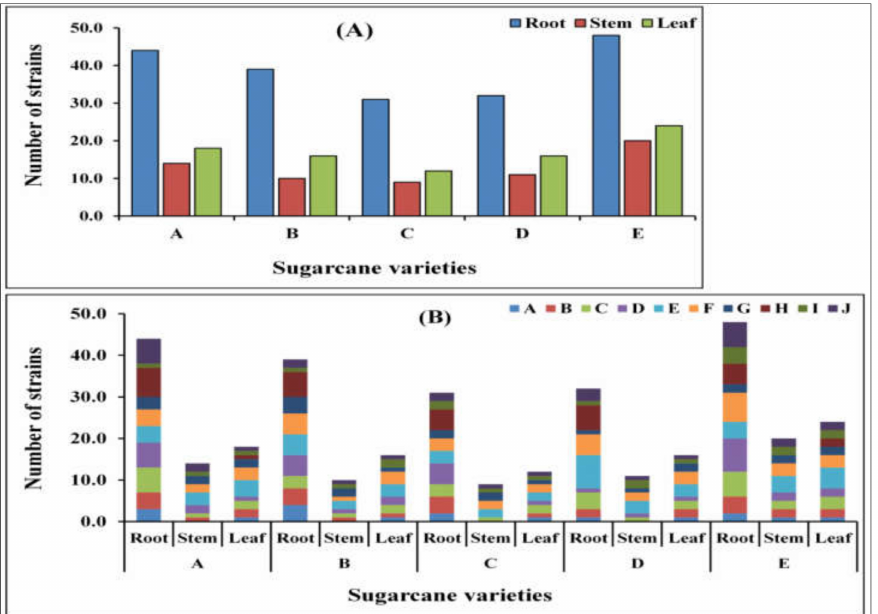
Figure 1. The total number of isolated endophytic bacterial strains. ( A ) Total number of bacterial strains isolated from different sugarcane species in different tissues, i.e., root, stem, and leaf. A. Saccharum officinarum L. cv. Badila, B. S. barberi Jesw.cv Pansahi, C. S. robustum , D. S. spontaneum , and (E) S. sinense Roxb.cv Uba). ( B ) Number of individual isolates from different tissues (root, stem, and leaf) in the different media: A. Ashby’s Glucose Agar, B. Ashby’s Mannitol Agar, C. Burk’s Medium, D. Jensen’s Agar, E. Nutrient Agar, F. Luria–Bertani Agar, G. Yeast Mannitol Agar, H. DF